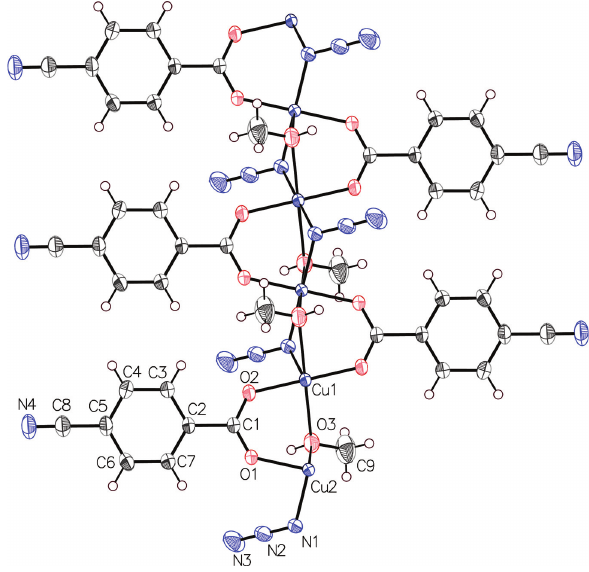
Table 1 contains crystallographic data and Table 2 contains the list of the atoms including atomic coordinates and dis- placement parameters.